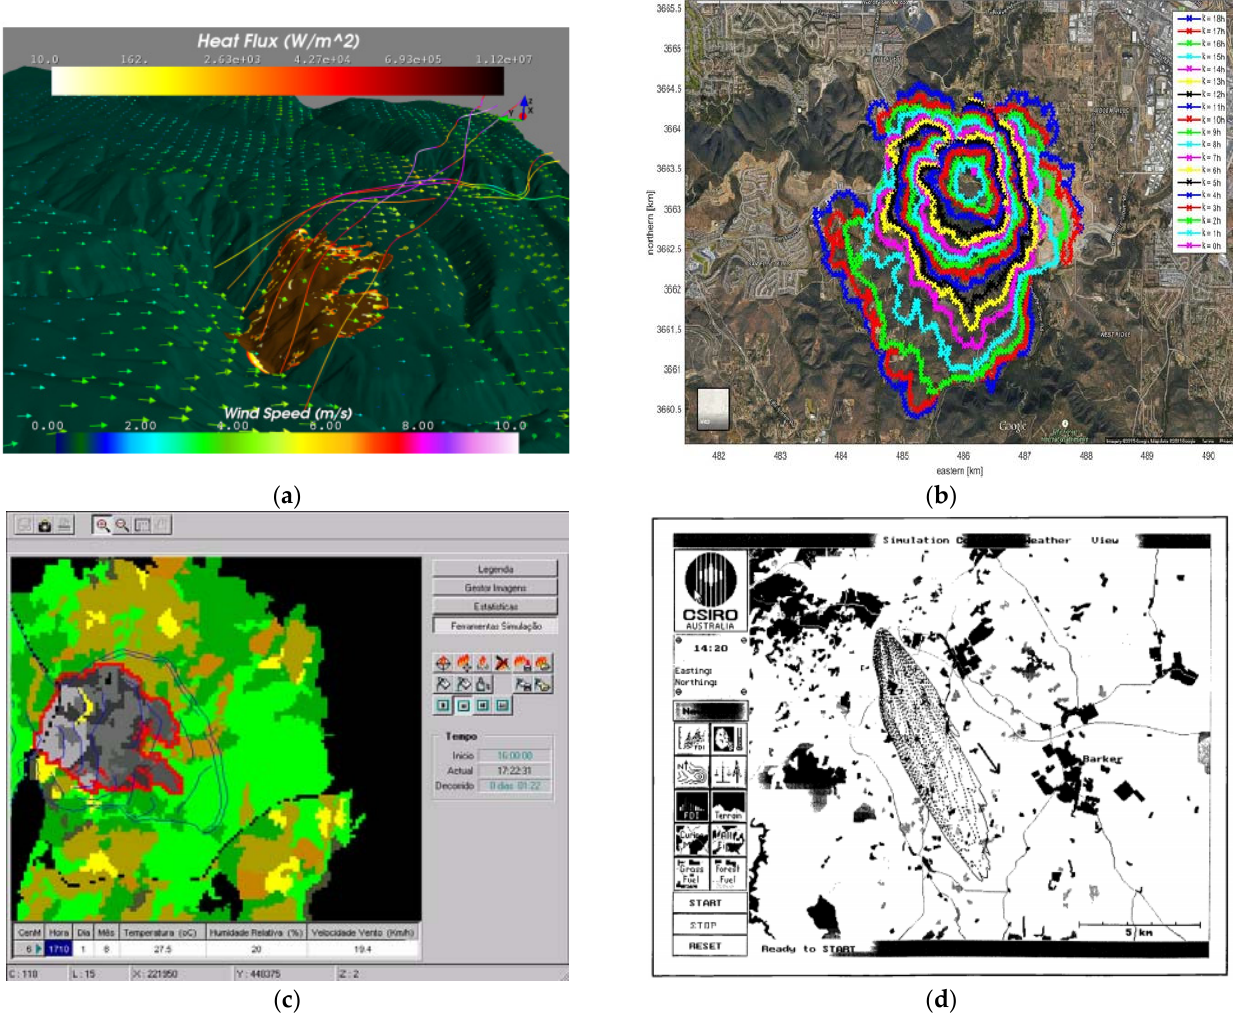
Figure 1. Some examples of presented fire software snap-shots. ( a ) Screenshot of WRF-Fire software: The finest domain in the Meadow Creek fire model 5 h following ignition. Burned fuel is shown as brown and unburned fuel as green, The thermal flux from the fire exists around the fire line. Arrows show the surface winds [87]. ( b ) Screenshot of Farsite software: a model of hourly fire perimeters on a 18 h period with a spatial resolution of 90 m along the fire perimeters commenced at an off-set initial fire perimeters [88]. ( c ) Screenshot of Geofogo software: Snapshots of a running simulation in Geofogo. The red line is ire fronts of the simulated fire [61]. ( d ) Screenshot of Sirofire software: The Sirofire user interface illustrated in white and black. A portion of Adelaide Hills database is illustrated with a fire commenced